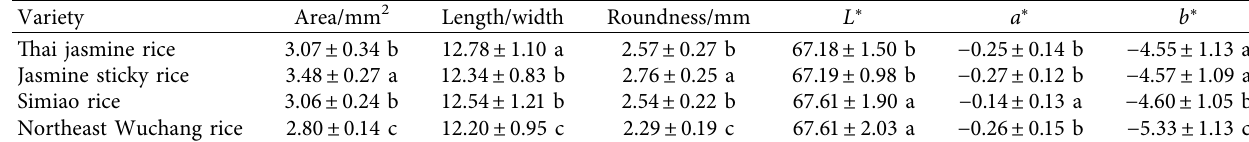
Table 1: Analysis of imaging features for four different varieties of rice.